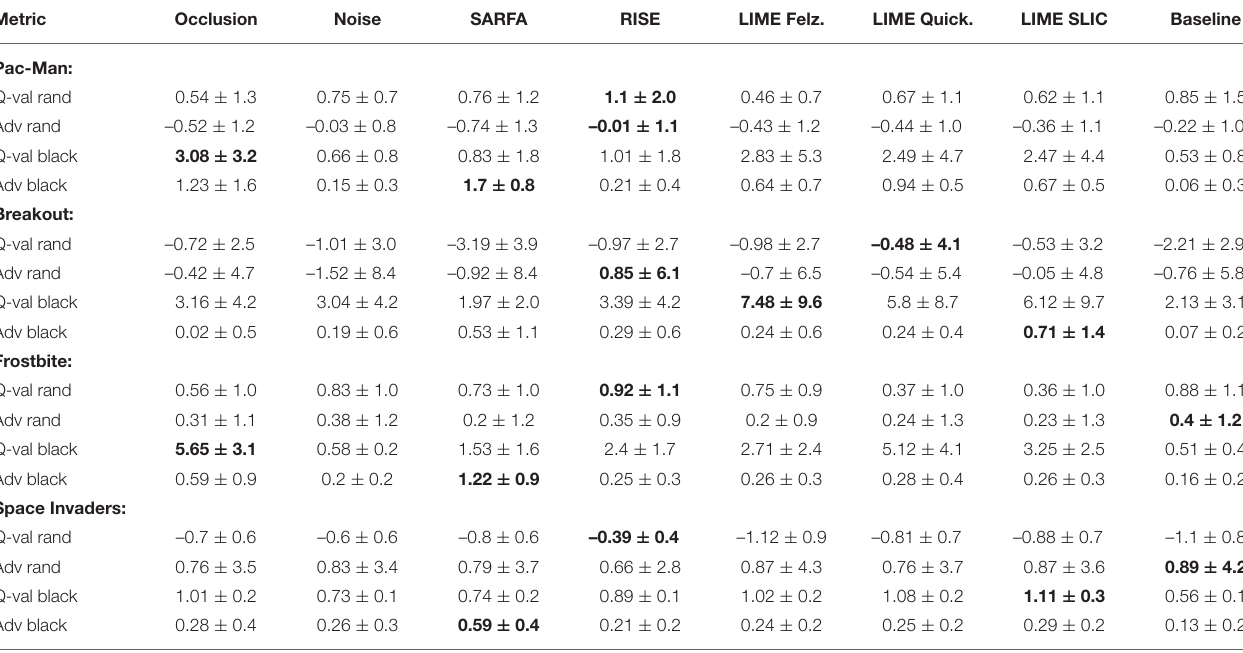
TABLE 8 | The sample mean and SD of the insertion metric curve for 1,000 states of each game. Metric Occlusion Noise SARFA RISE LIME Felz. LIME Quick. LIME SLIC Baseline